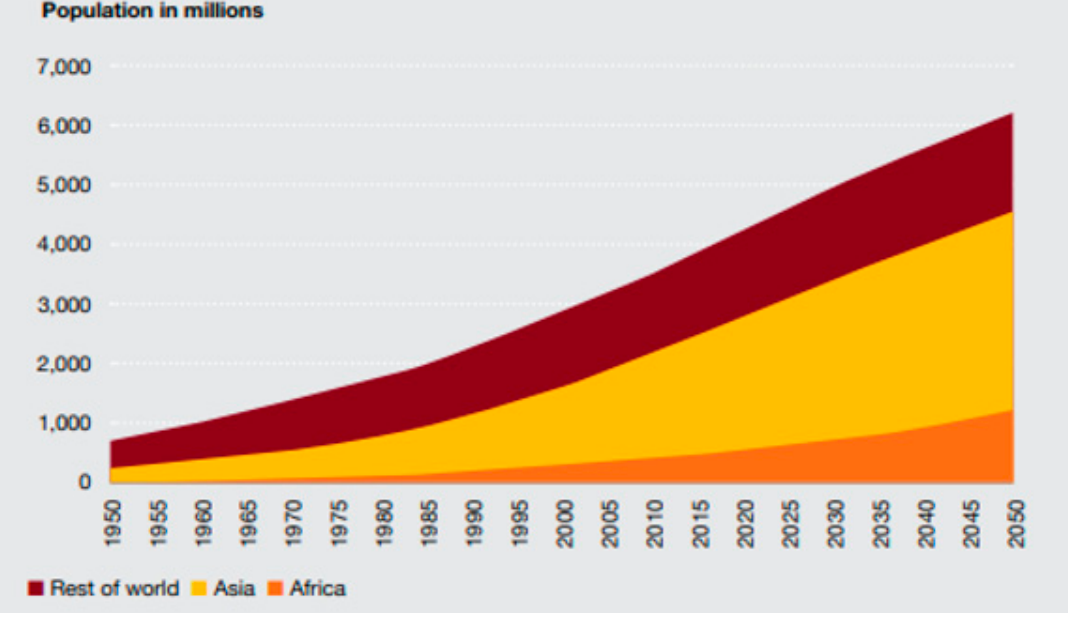
Figure 1. World Urban Population from 1950–2050.Source: PWC [18].